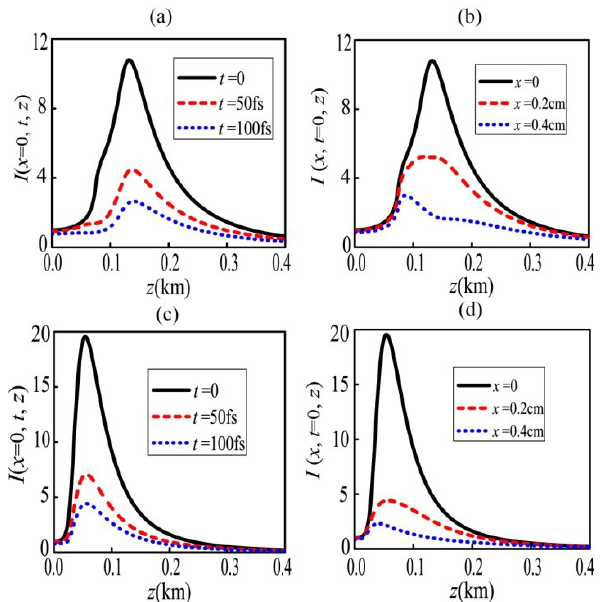
Figure 9. On-axis and off-axis normalized spatial-temporal intensity profile I ( x , t , z ) of PCP beams at z plane with different values of t ( a , c ) and x ( b , d ).